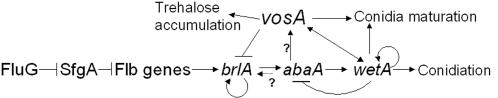
Model for regulation of conidiation (see text).